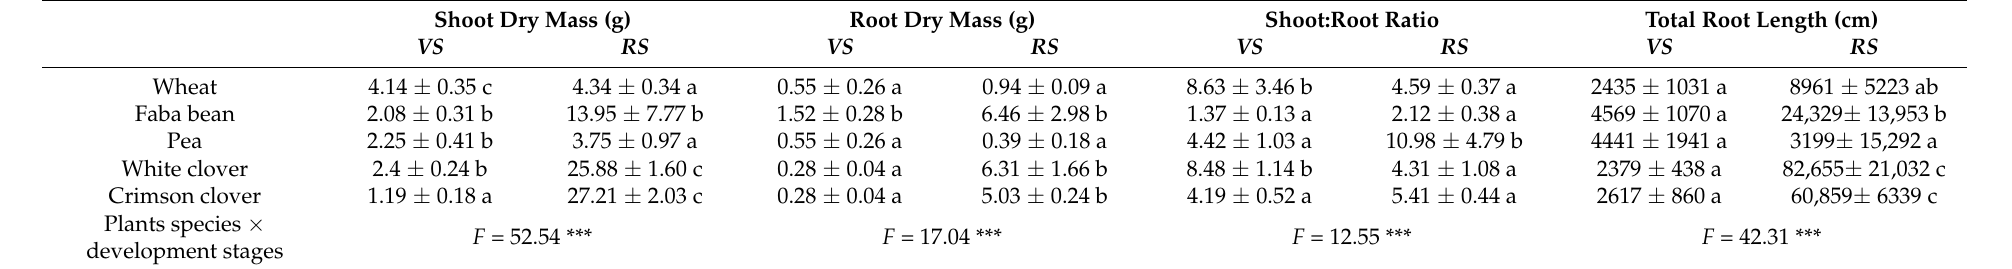
Table 2. Plant traits including shoot and root total dry mass per pot, shoot to root ratio and total root length for all studied plants species. Shoot Dry Mass